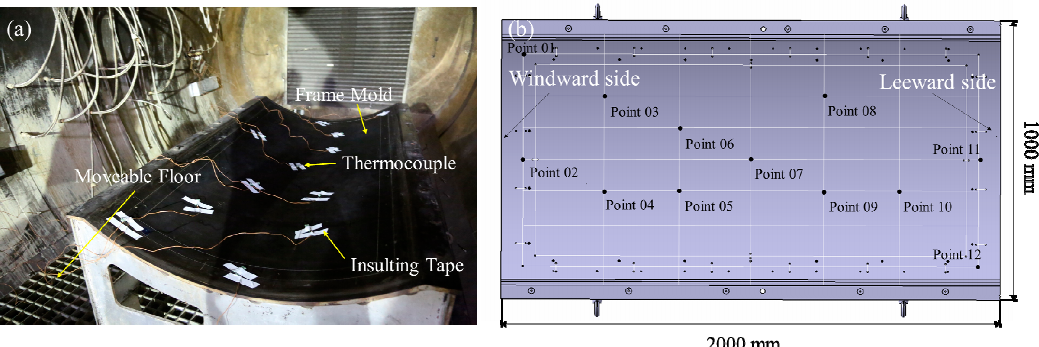
Figure 1. ( a ) The autoclave experiment setup, ( b ) a schematic of the mold with 12 measurement